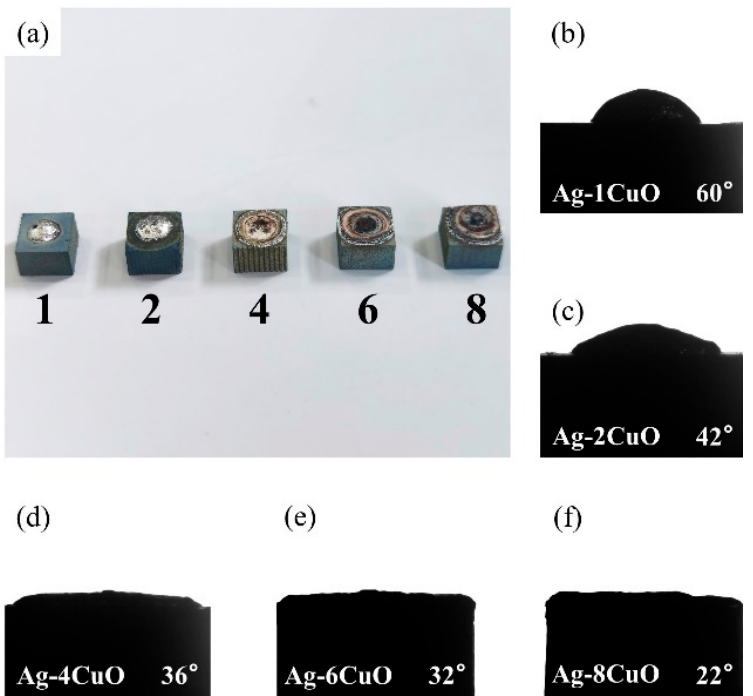
Figure 3. Contact angles of Ag-CuO fillers on TiAl: ( a ) macroscopic appearance of the specimens,